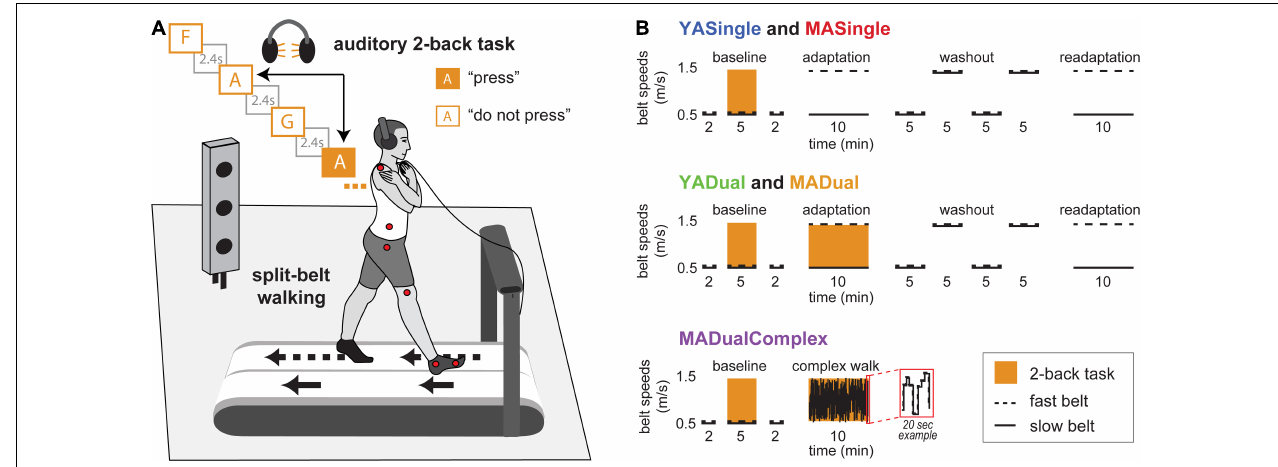
FIGURE 1 | Experimental setup and paradigm. (A) Setup for walking and 2-back tasks. Participants walked on the split-belt treadmill with one belt (dashed arrow) moving faster than the other belt (solid arrow), and kinematics were recorded using markers positioned as shown (red circles). In the 2-back task, participants heard a string of letters through headphones, and were tasked to press a mouse button every time a letter was the same as 2 letters before. In the example shown, the participant should press the button on the second presentation of letter “A.” (B) Protocol for groups in Experiment 1 (YASingle and YADual) and Experiment 2 (MASingle, MADual, MADualComplex). Black lines show treadmill belt speeds throughout the experiment (solid: slow; dashed: fast). Orange blocks indicate phases when participants performed the 2-back